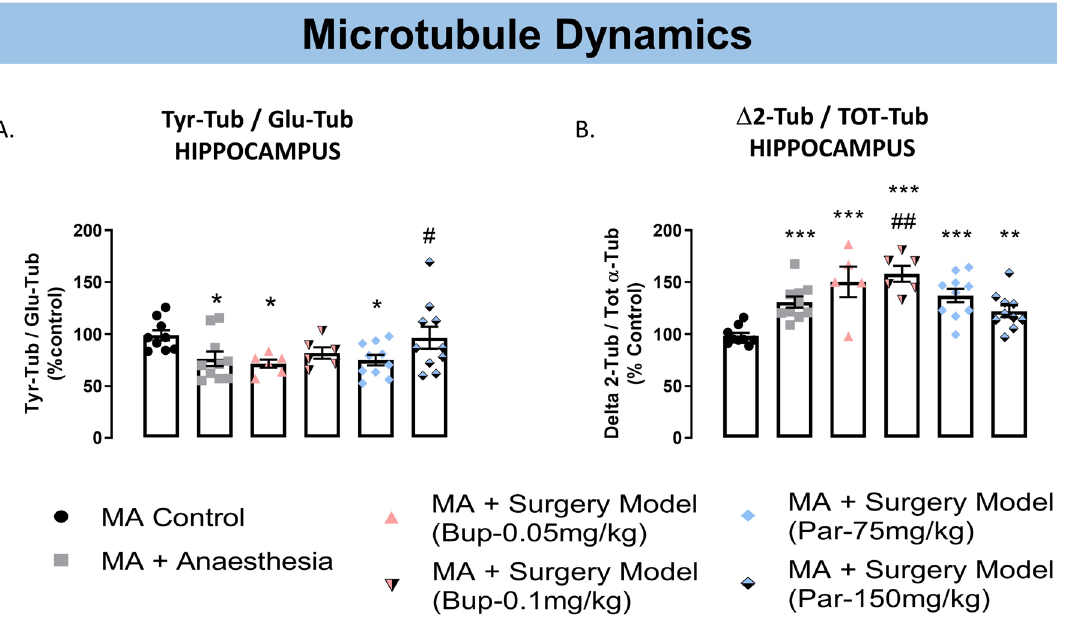
Figure 5. Hippocampal α-tubulin PTMs are altered following exposure to anaesthesia or surgery. ( A ) Tyr-Tub/ Glu-tub ratio is decreased in MA animals exposed to anaesthesia only and in the surgery model groups treated with Bup-0.05 mg/kg or Par-75 mg/kg compared to MA control. ( B ) Δ2/TOT-Tub ratio is increased in MA animals exposed to anaesthesia only and in the surgery model groups treated with Bup-0,05 mg/kg or Bup- 0.1 mg.kg (s.c.) or Par-75 mg/kg or Par150mg/kg (i.p.) compared to MA control. Surgery animals treated with Bup-0.1 mg/kg had significantly higher Δ2/Tot-Tub ratio compared to MA animals exposed to anaesthesia only. Histograms represent data expressed as a percentage of the MA Control group (mean ± SEM), n = 10–12 per group. One-way ANOVA followed by Fisher’s LSD analysis ***p < 0.0001, **p < 0.01, *p < 0.05 vs. MA control; # p < 0.01, ## p < 0.01 vs. MA + Anaesthesia